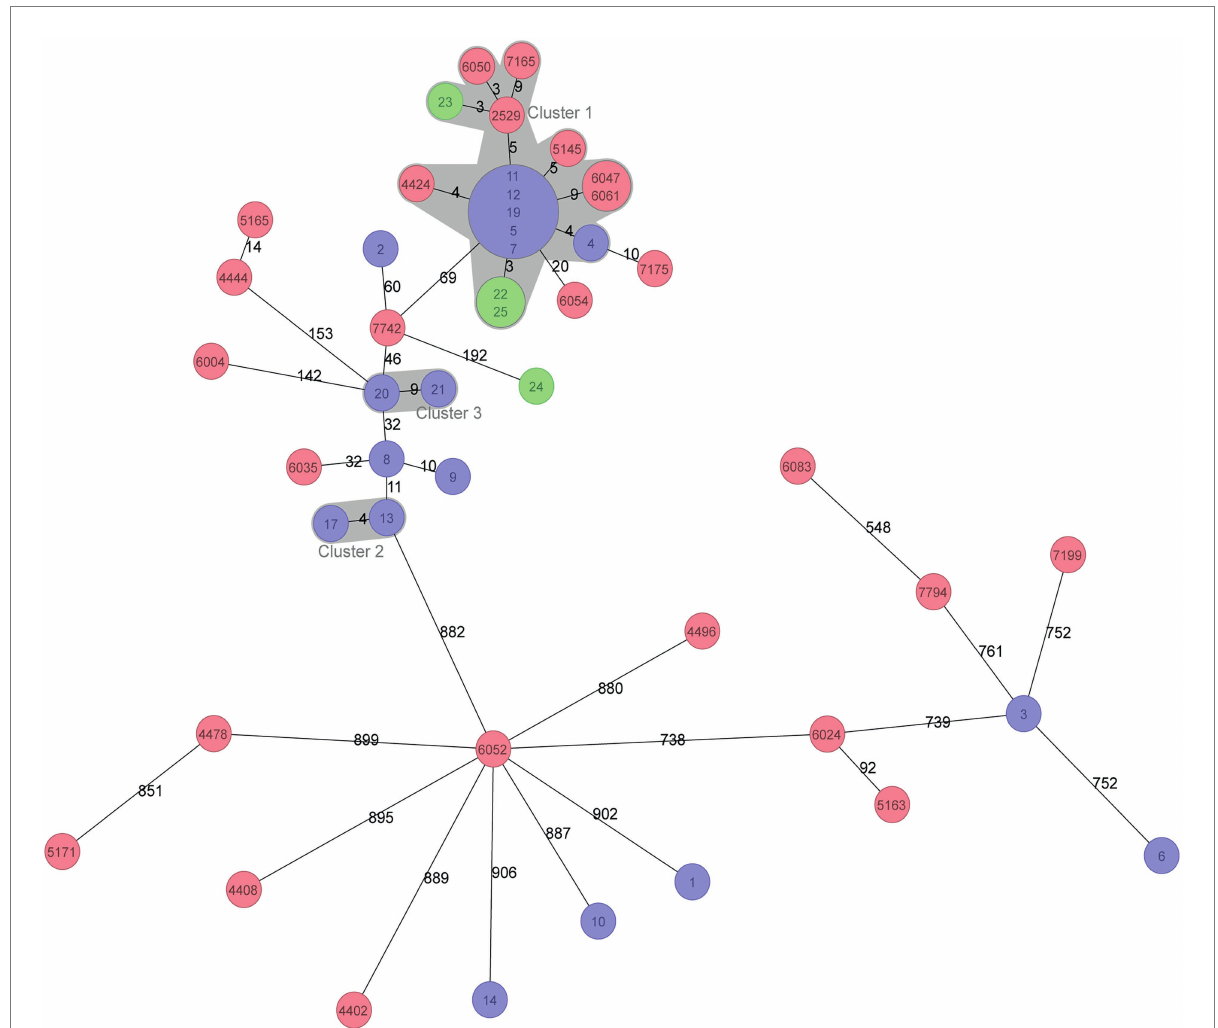
FIGURE 1 Minimum spanning tree of 47 BSI Acinetobacter baumannii isolates based on cgMLST. cgMLST profiles are represented by circles, and the isolate name is marked on the circle. The size of the circle is proportional to the number of isolates with an identical cgMLST profile. The different colours in the circle represent the three hospitals from which the isolates were collected. The number on the line connecting the cgMLST circles is the number of core genes that differ between the isolates within the circles. The grey zone surrounding a group of circles represents the closely related isolates that differed by less than ten core